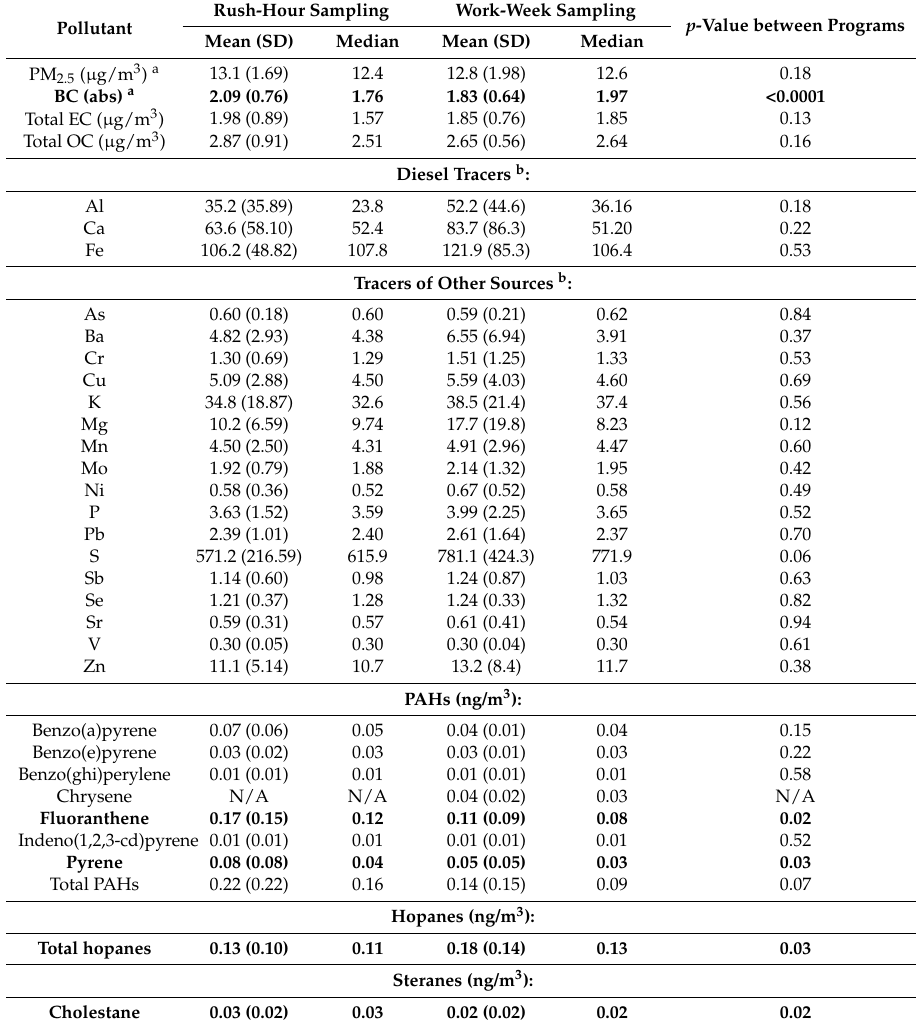
p -Value between Programs